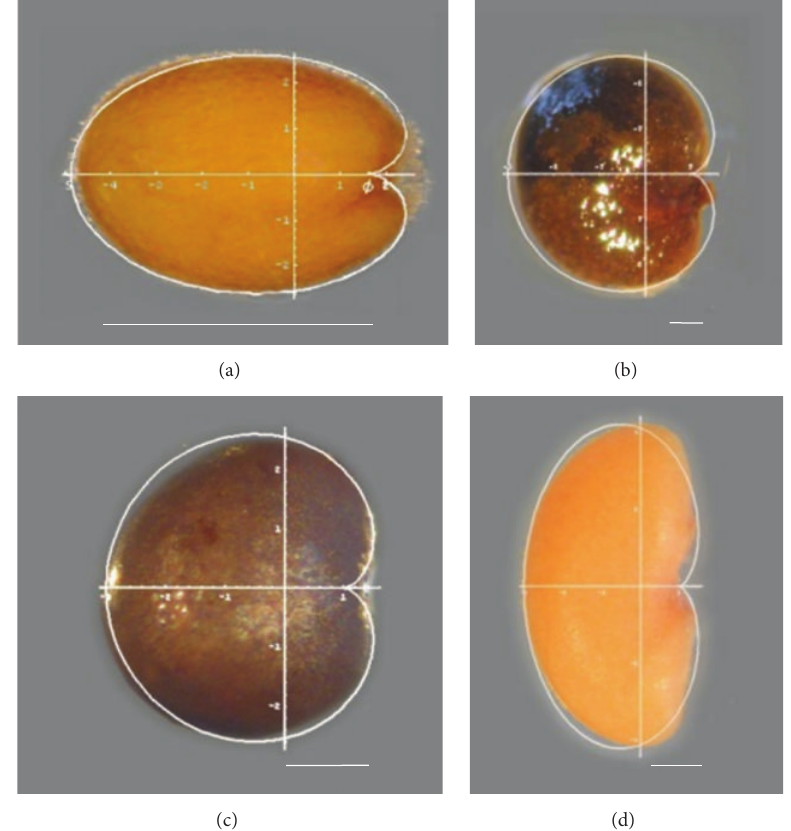
Figure 3: Cardioid or cardioid derived models applied in (a) Arabidopsis thaliana seeds, a cardioid elongated in the 𝑥 -axis for a factor of Phi (1,618) [7]; (b) Capparis spinosa , a cardioid [8]; (c) Lotus japonicas , a cardioid [9]; and (d) Medicago truncatula , a cardioid curve elongated in the 𝑦 -axis for factor of Phi [9]. Scale bar represents 0.5 mm.